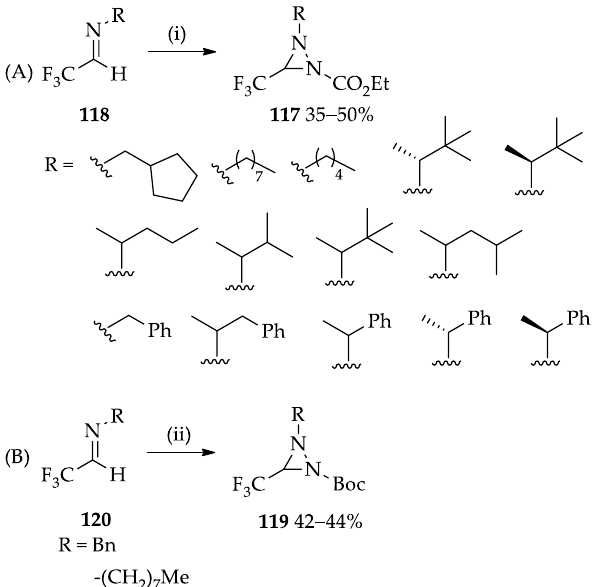
Scheme 8. Trifluoromethyled N , N -disubstituted diaziridines synthesis. ( A ) ethyl carbamate, ( B ) tert - butyl carbamate. Conditions: (i) NsONHCO 2 Et (molar ratio to imine 2:1), CH 2 Cl 2 , rt, 16 h; (ii) NsONHCO 2 t -Bu (molar ratio to imine 2:1), CH 2 Cl 2 , rt, 12